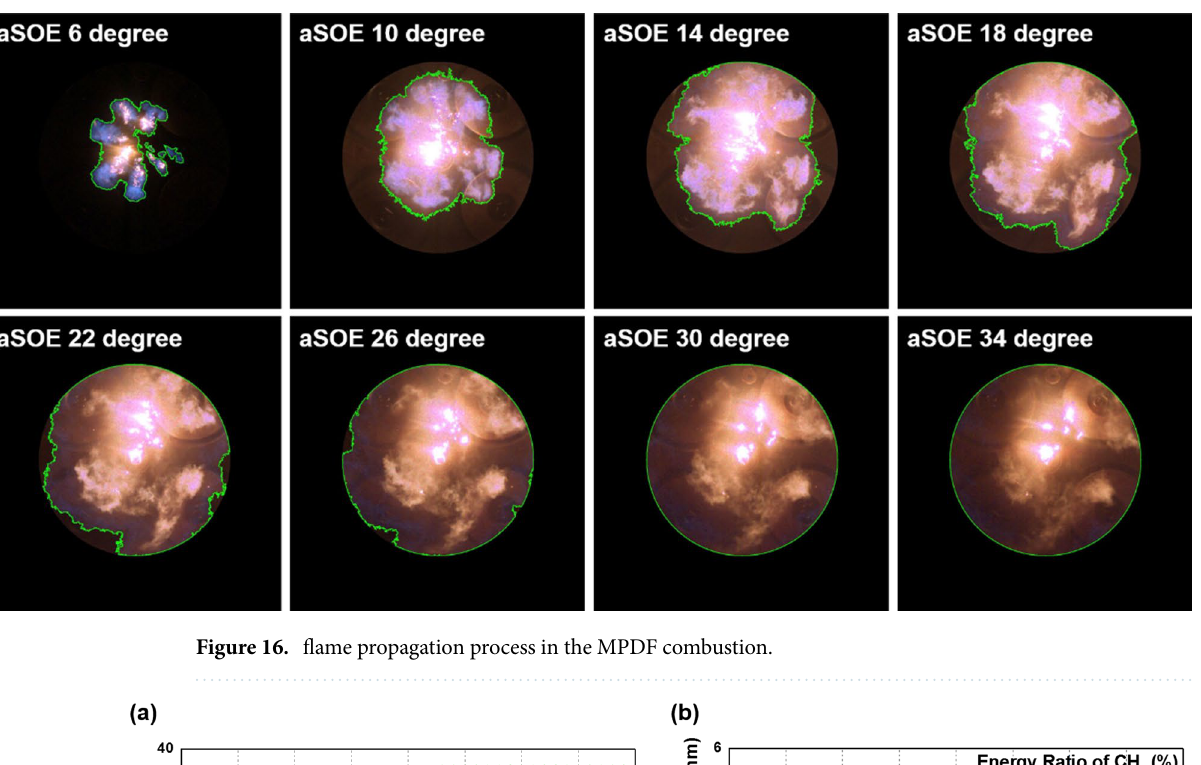
Figure 16. flame propagation process in the MPDF combustion.